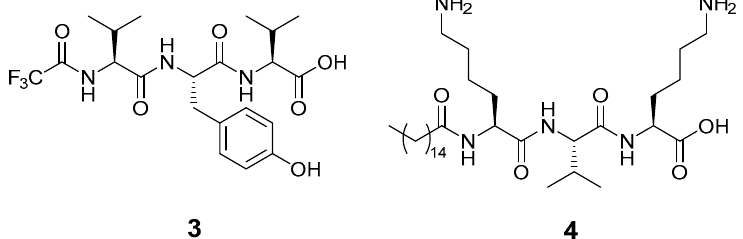
Figure 4. Chemical structure of the active peptides 3 and 4 described in this work.